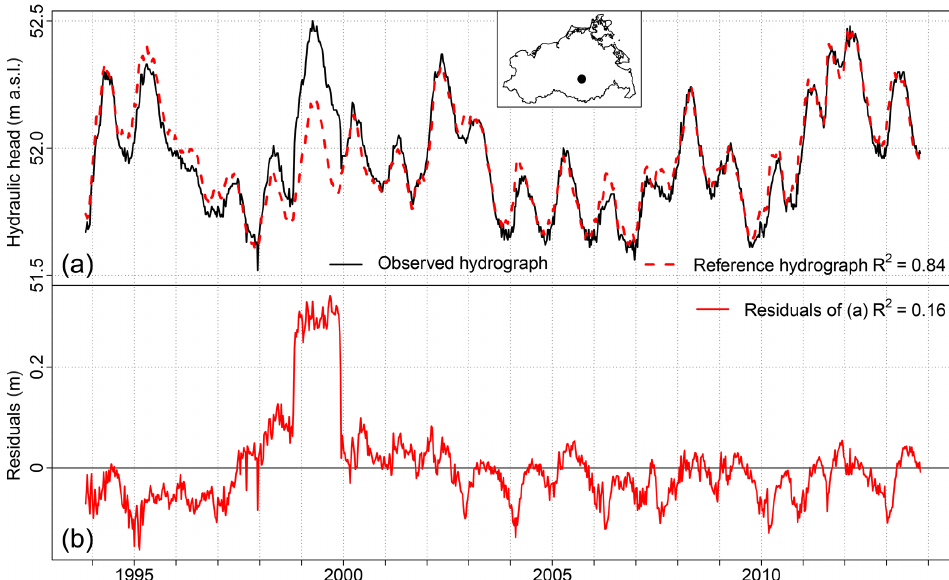
Figure 6. (a) Time series of the hydraulic head and the reference hydrograph of well Deven. (b) Time series of residuals. Location of the well is marked as a black dot in the inset map. Height of the well head at well Deven is 61.48ma.s.l. Correlation of the observed series with the reference hydrograph and with the residuals is given as R 2